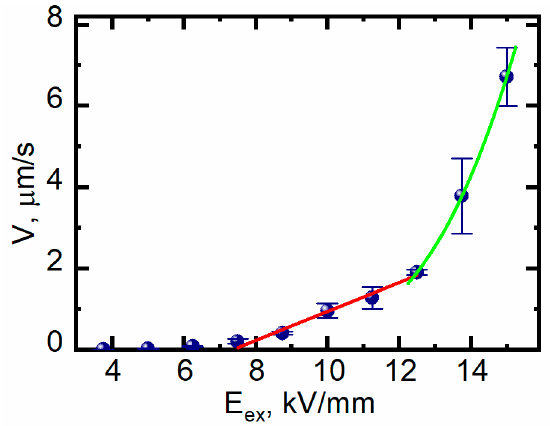
Figure 10. Field dependence of the slow Y- wall velocity fitted by Equation ( 1 ) (red line) and Equation ( 2 ) (green line).